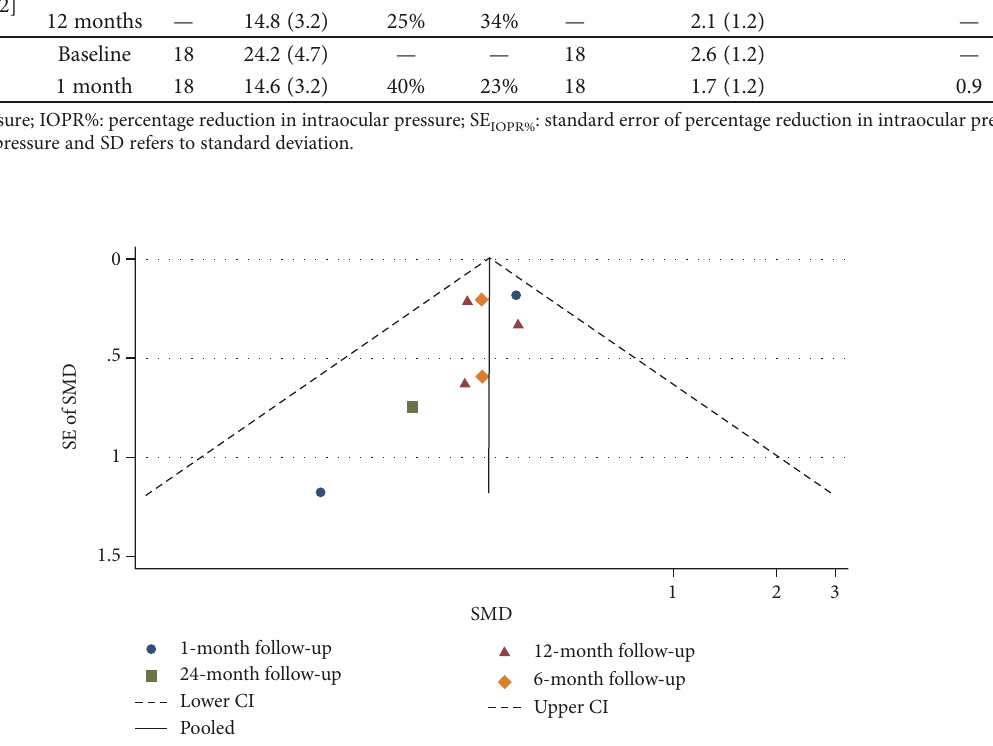
Figure 2: Funnel plot for studies examining change in intraocular pressure (mmHg) by follow-up (months). The dashed line represents the con fi dence interval